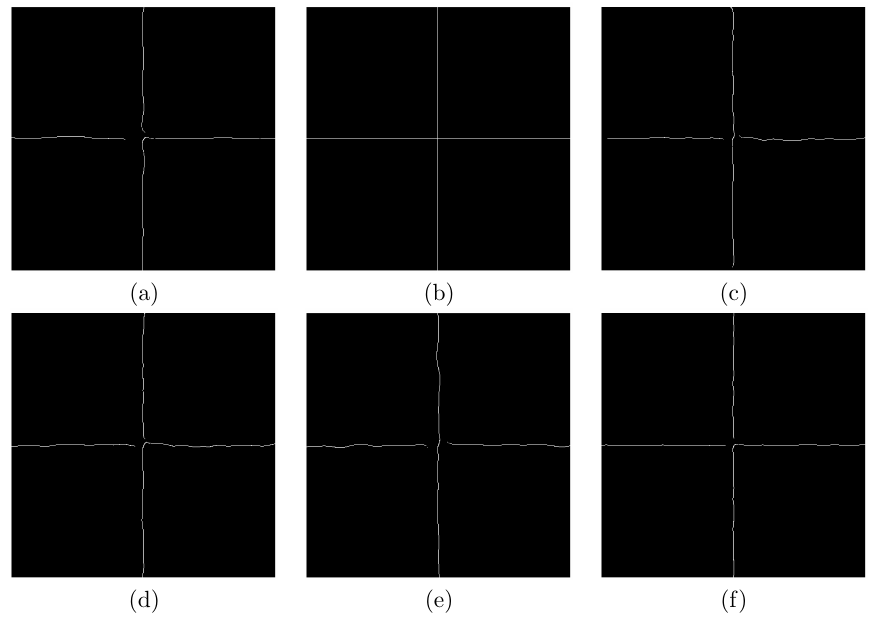
Figure 5. Squares test case: edge maps obtained for: ( a ) noisy SAR image, ( b ) clean, ( c ) Kuan, ( d ) PPB-it, ( e ) FANS, and ( f )